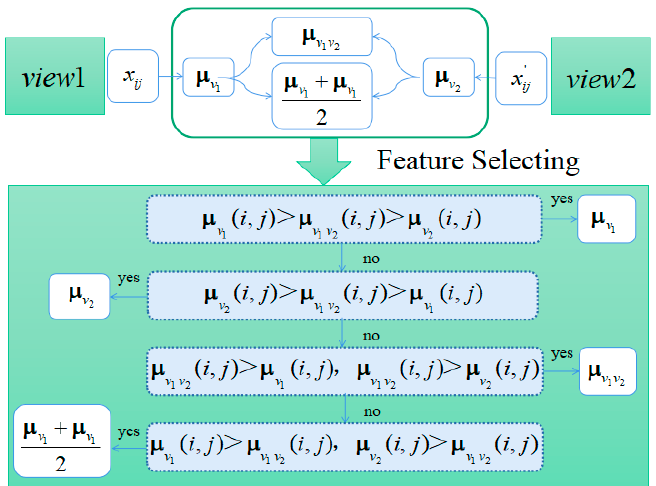
Figure 3. Membership function value selecting under the joint view.